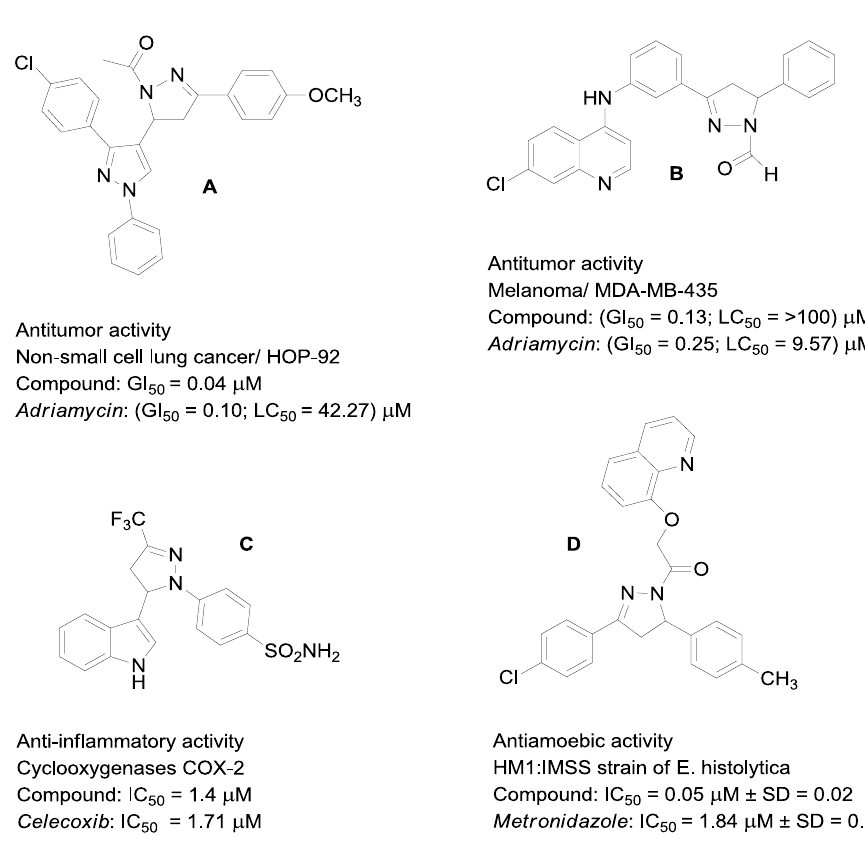
Figure 1. Some pyrazolines with remarkable biological